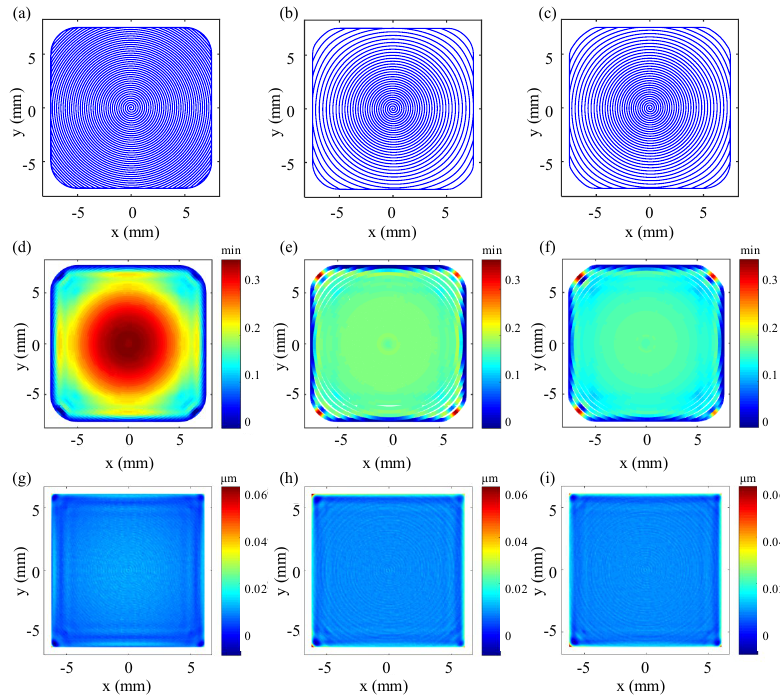
Figure 9. ( a ) Boundary-defined unoptimized path with constant pitch; ( b ) RMS-map-based optimized path with varying pitch; ( c ) PV-map-based optimized path with varying pitch; ( d ) dwell time map along the unoptimized path; ( e ) dwell time map along the RMS-map-based optimized path; ( f ) dwell time map along the PV-map-based optimized path; ( g ) residual error corresponding to the unoptimized path; ( h ) residual error corresponding to the RMS-map-based optimized path; ( i ) residual error corresponding to the PV-map-based optimized